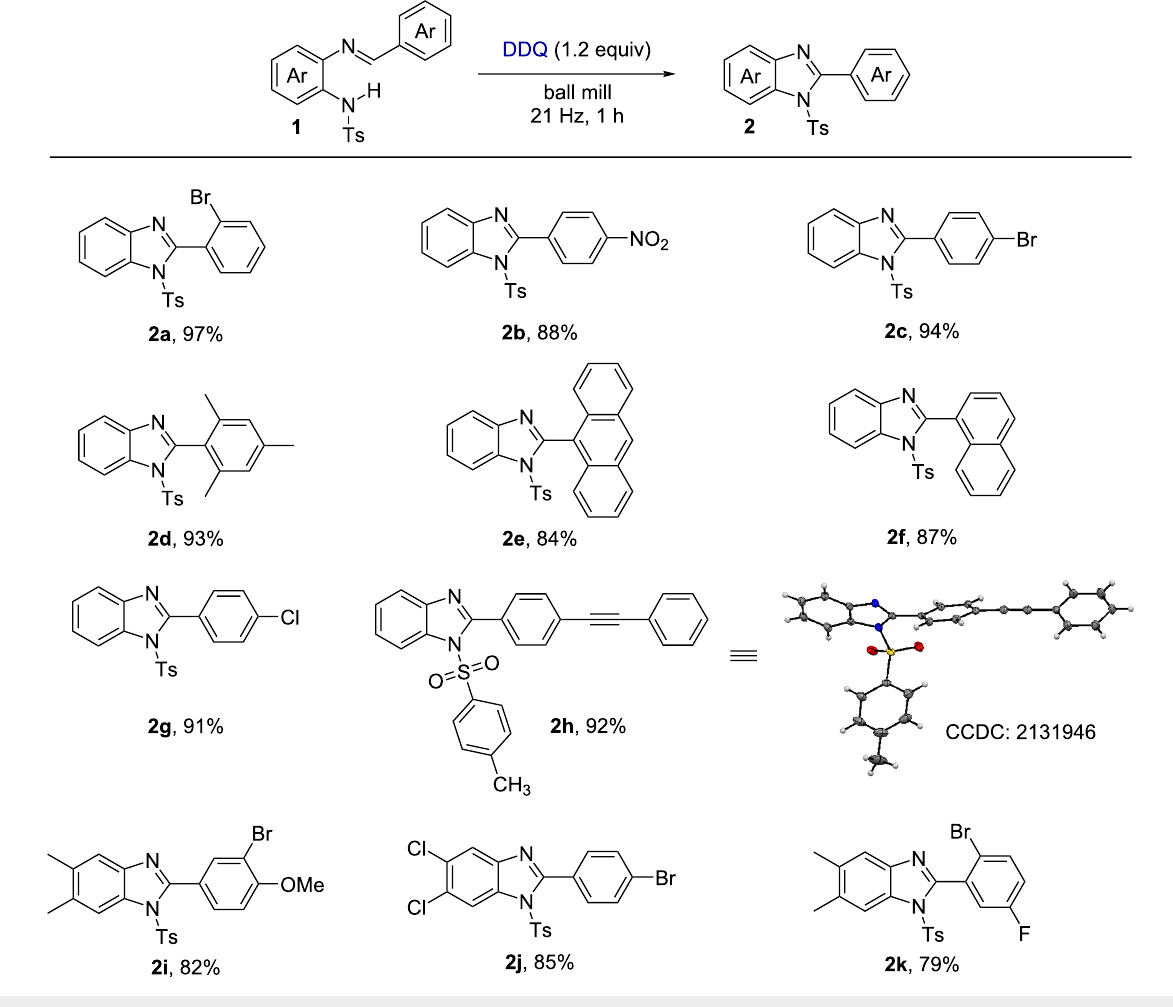
Figure 2: Scope of the mechanochemical synthesis of substituted